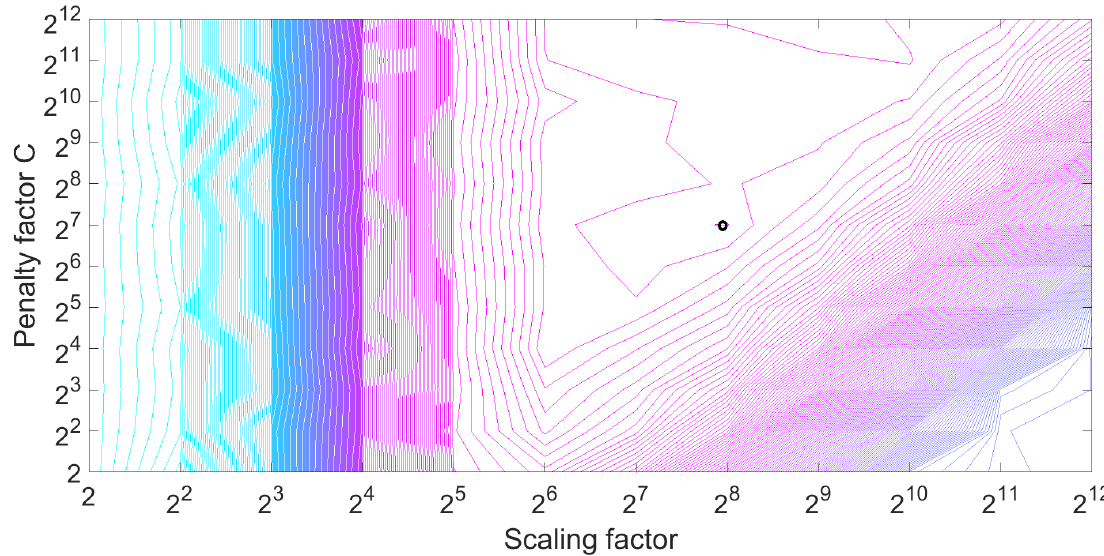
Figure 7. Optimization of the scaling factor and the penalty factor for